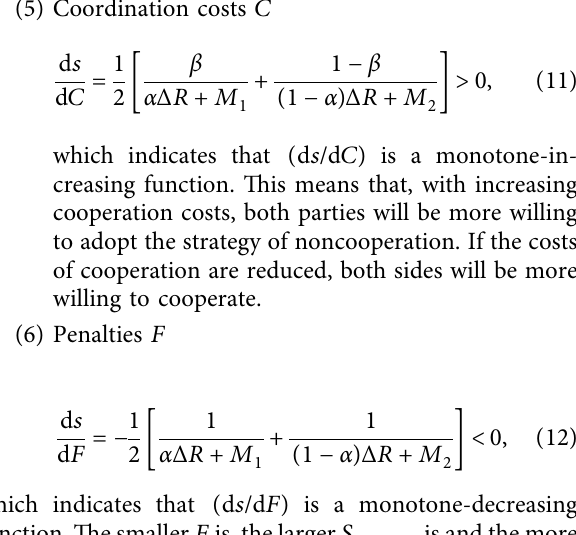
shows the development of